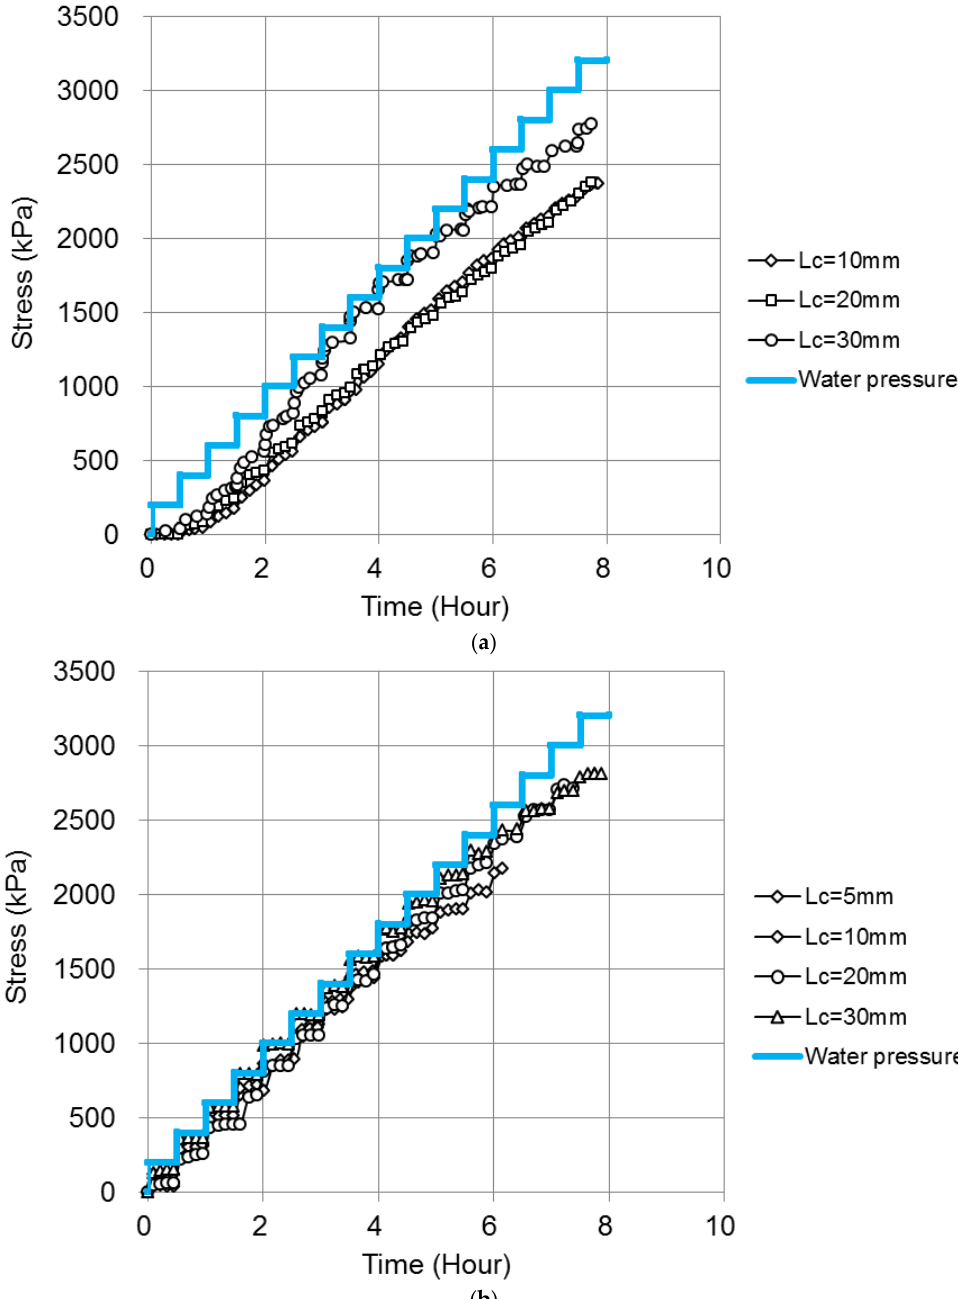
Figure 2. Curves of applying water pressure (200 kPa per 0.5 h) and induced average vertical stress at the top of the specimens with different ring crack depths vs. time at ( a ) 5 °C and ( b ) 20 °C, re- spectively.